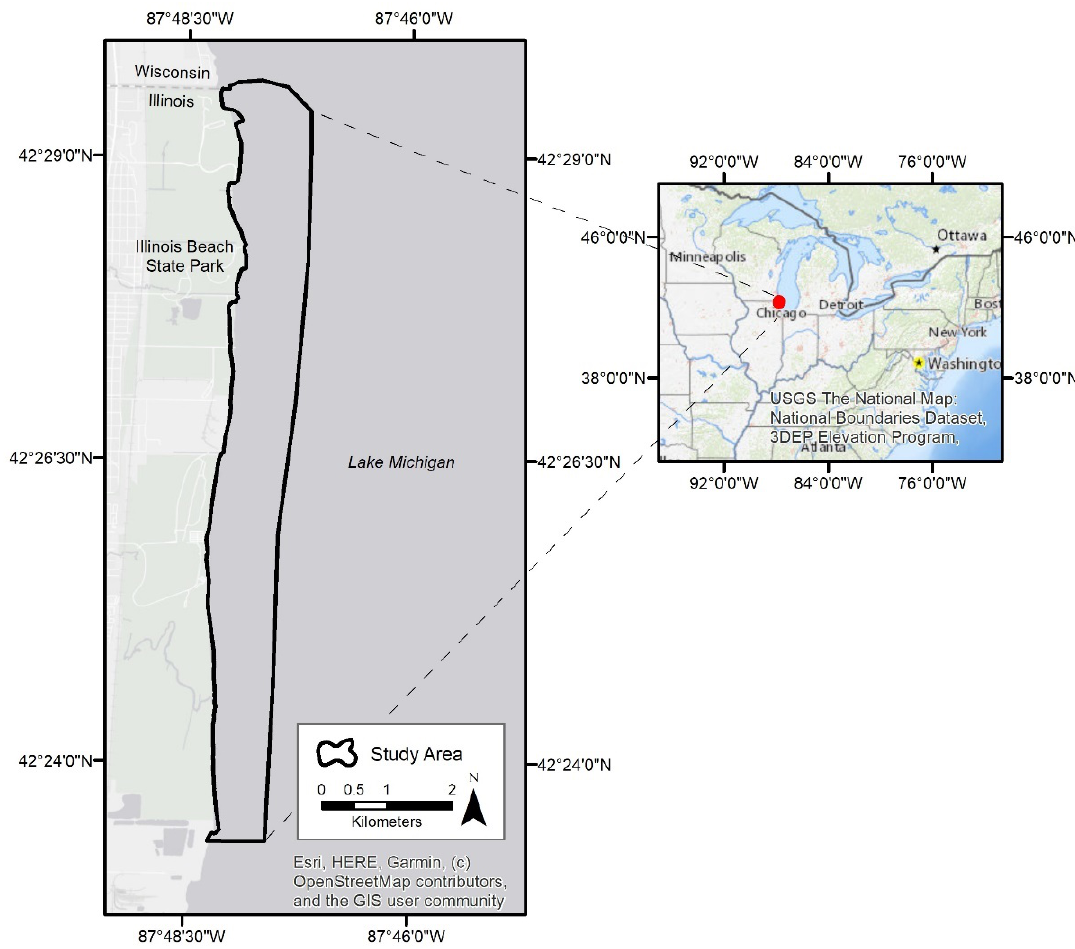
Figure 1. Study area at southwest Lake Michigan, USA.